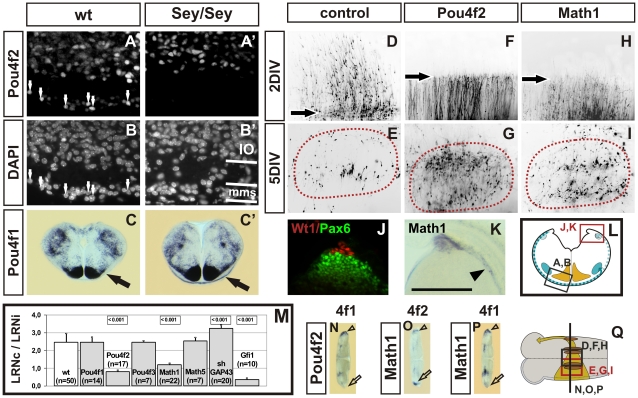
Pou4f2 induces a midline arrest of neurons in the mms.Immunohistochemical labeling of Pou4f2 on coronal wt (A) and Pax6Sey/Sey (A′) E14.5 sections counterstained with DAPI (B and B′, respectively); high magnifications of the ventral mms are shown as indicated in (L). Pou4f2 is expressed in E14.5 wt embryos in neurons of the inferior olive (IO) and in a fraction of migrating mms neurons (white arrows in A and B). In Pax6Sey/Sey embryos Pou4f2 is expressed in the IO but not in neurons of the mms (A′,B′). In situ hybridization of coronal wt (C) and Pax6Sey/Sey (C′) E15.5 sections reveals that Pou4f1 expression is massively up-regulated in Pax6Sey/Sey embryos (arrow in C, C′). Over-expression of Pou4f2 (F) and of Math1 (H), but not of control constructs (D), result in a complete arrest of growth cones at the midline (black arrows in F and H) after 2DIV. In control cultures after 5DIV few cells settle in the ipsilateral LRN (LRNi) (E), whereas, in cultures over-expressing Pou4f2 or Math1 a significant higher proportion of cells settles in the LRNi (G, I). (J, K) Distribution of Wt1, Pax6 and Math1 on coronal wt E14.5 sections as indicated in (L). (J) Immunohistochemical labeling of Pax6 (green) and Wt1 (red) indicates that Wt1 is expressed in the roof plate dorsally to the rhombic lip and that Pax6 and Wt1 are non-overlapping. (K) In situ hybridization with Math1 indicates that Math1 is expressed at the rhombic lip and in a subset of cells emanating from the rhombic lip (arrowhead in K). (M) Quantification of mms neurons settling in the LRN; values are given for the proportion of cells settling in the LRNc or LRNi. The significance of changes is indicated by a p-value of <0.001; values are ±SEM. Over-expression of Pou4f2, Math1, and Gfi1 resulted in a higher ratio of LRNi cells and down-regulation of Gap43 led to a lower ratio of LRNi cells. (N-P) In situ hybridization of sectioned cultures after over-expression of Pou4f2 or Math1. Pou4f1 expression is reduced in Pou4f2 and in Math1 transfected rhombic lips (open arrows in N,P), but not in the control rhombic lip (open arrowheads in N,P). Pou4f2 is up-regulated in Math1 transfected (open arrow in O) but not in control (open arrowhead in O) rhombic lips. (Scale bar is 110 µm in [A, A′, B, B′, J, K]; 1,4mm in [C, C′, N, O, P].); 440 µm in [D–I].)